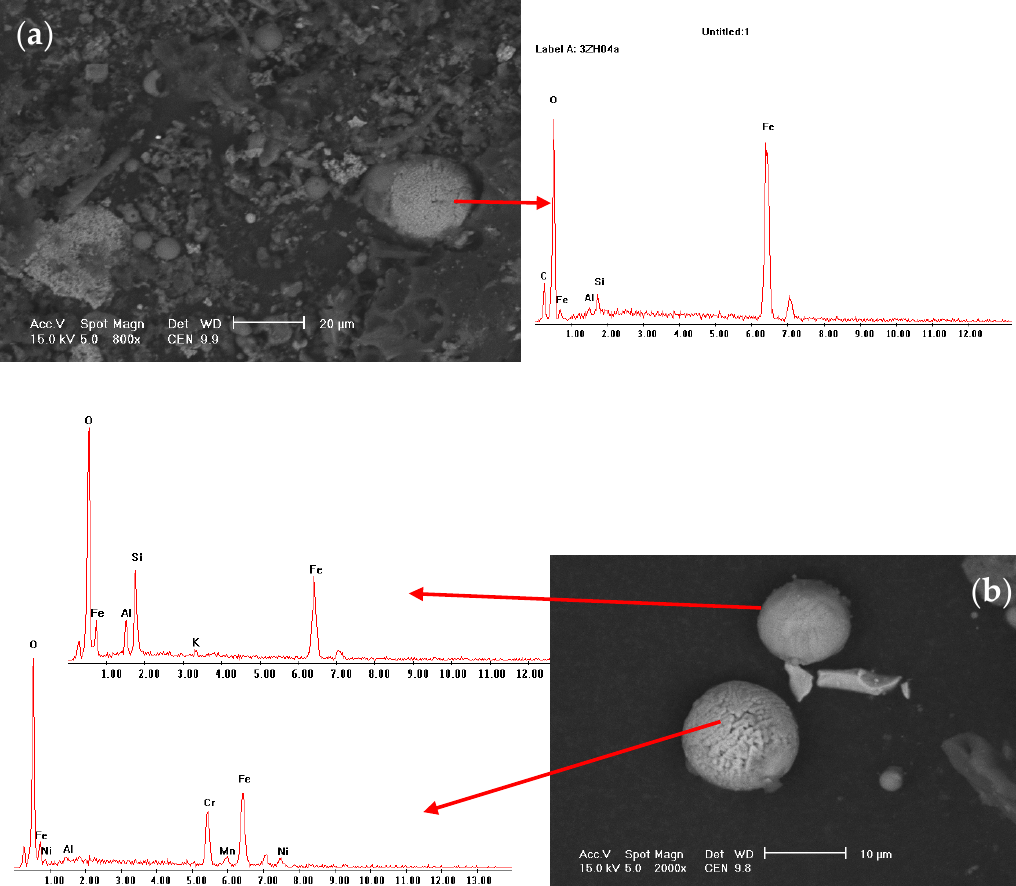
Figure 1. Magnetic phase of fly ashes after hard coal combustion: ( a ) aluminosilicate sphere with a thin coating of magnetite; ( b ) the upper spherule consists of aluminosilicates with a thin coating of iron oxide, the lower spherule consists of iron oxide, chromium, nickel and trace amounts of manganese. The content of individual analyzed elements in dust from hard coal and lignite power plants di ff ered and was higher in samples of ash after hard coal combustion (except for cadmium) (Table 2). − 1 The content of zinc in ashes after burning lignite ranged from 159 to 164 mg · kg , and the content − 1 in ashes after burning hard coal was higher and ranged from 187 to 244 mg · kg . Total lead content − 1 ranged from 73 to 114 mg · kg in ashes from the lignite power plant and from 97 to 117 mg · kg -1 in ashes from the hard coal power plant. The cadmium content in both types of analyzed dust ranged from 4 to 18 mg·kg − 1 , and chromium from 80 to 105 mg·kg − 1 . Copper content in ashes from the lignite − 1 power plant ranged from 50–60 mg · kg . In ashes after hard coal combustion, the copper content was slightly higher and ranged from 78 to 91 mg·kg − 1 . Although the above values are high, it should be taken into account that the ash samples were collected from various electrostatic precipitators where these dusts were trapped and not emitted to the atmosphere. However, until the 1990s, power plants were not equipped with such efficient filters and most of the pollutants emitted ended up in the air and eventually deposited in the soil.